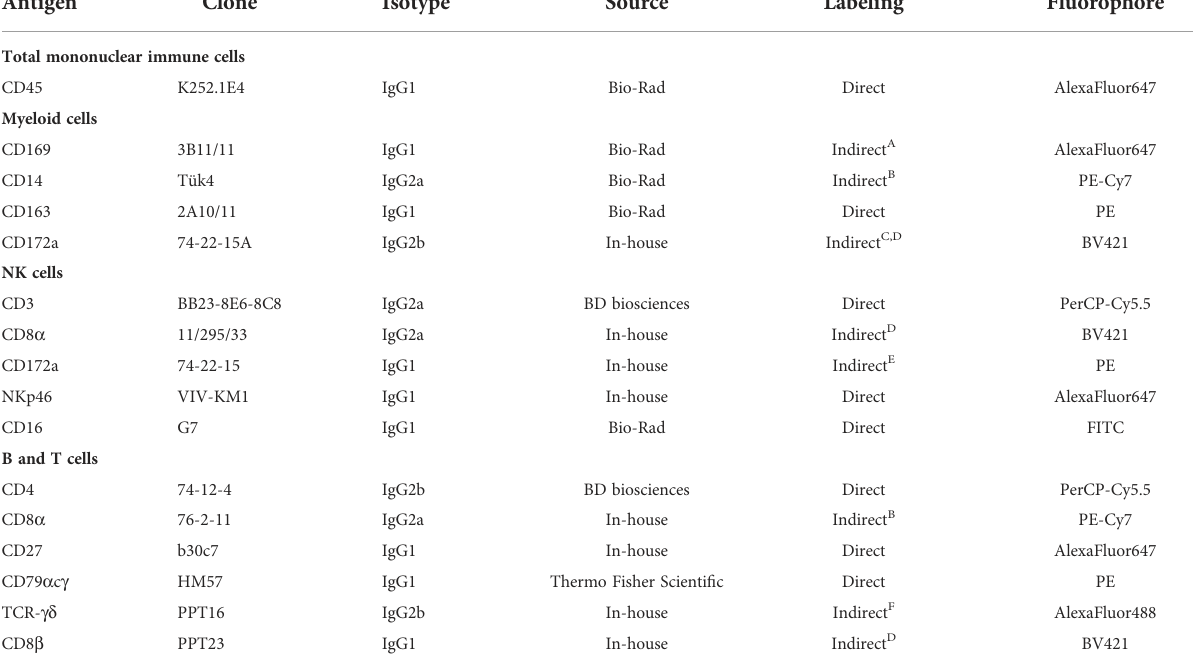
TABLE 3 Antibodies and secondary reagents used for FCM staining.